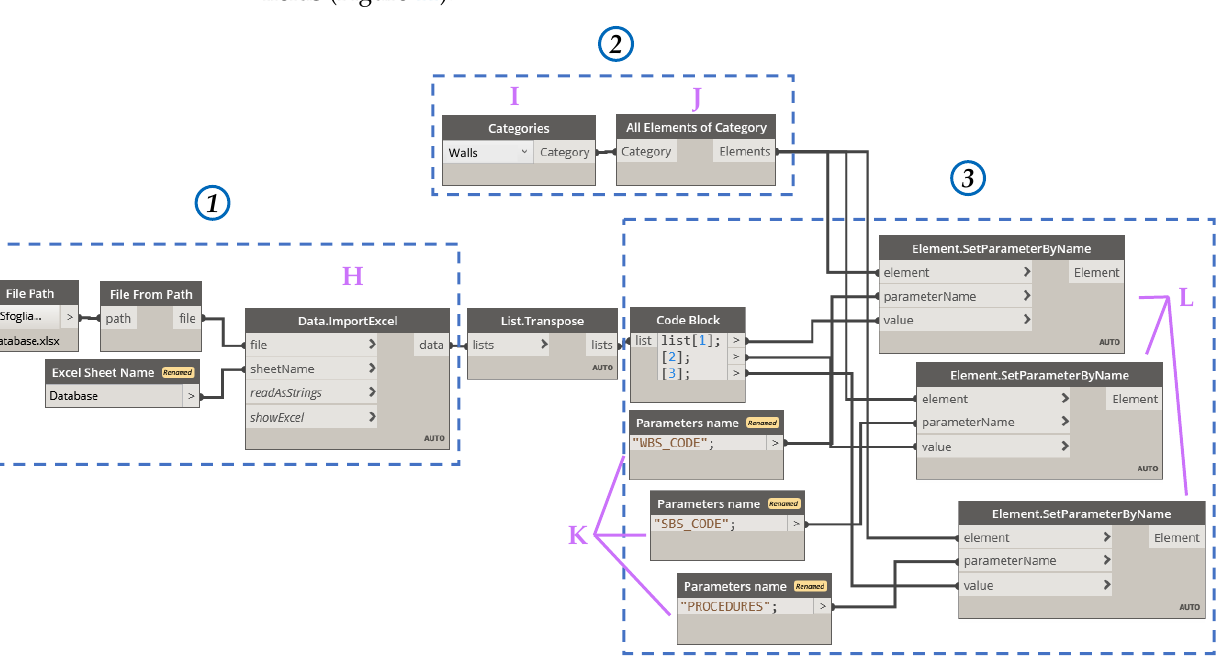
Figure 10. Dynamo structure for linking the parametric model to the database. Indeed, the information can be extracted from the central database and attached to the corresponding Revit object, such as a technical element, a room, etc. Due to specific Dynamo nodes, it was also possible to obtain automatic compiling of the objects’ related fields (Figure 11).